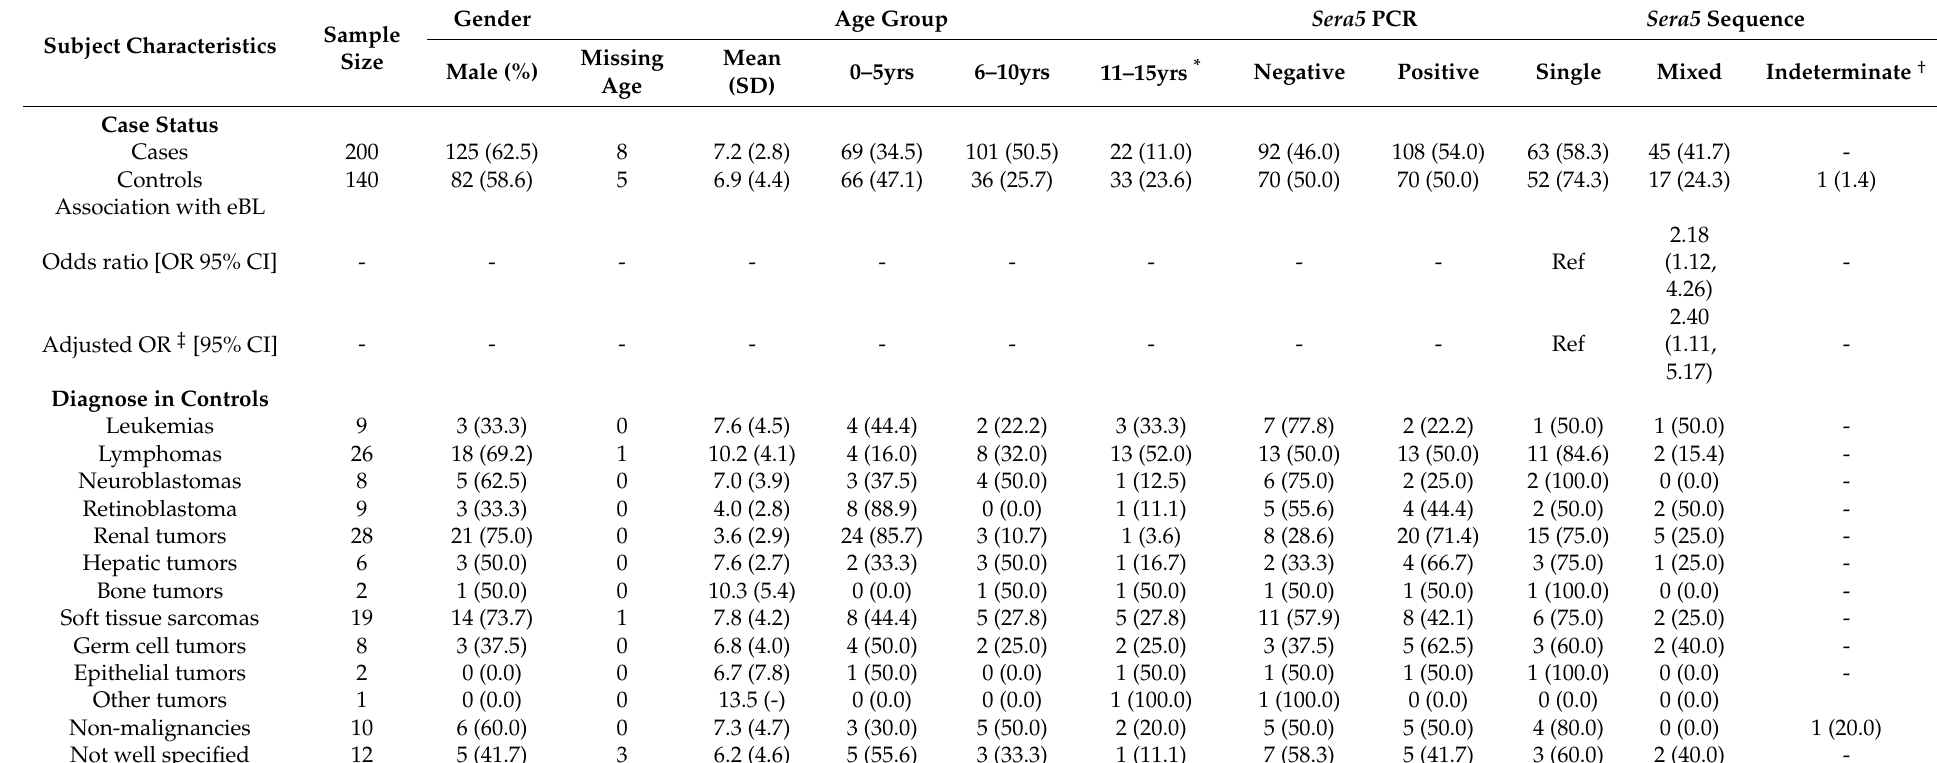
Table 1. Characteristics of Malawi and Mozambique samples used in this